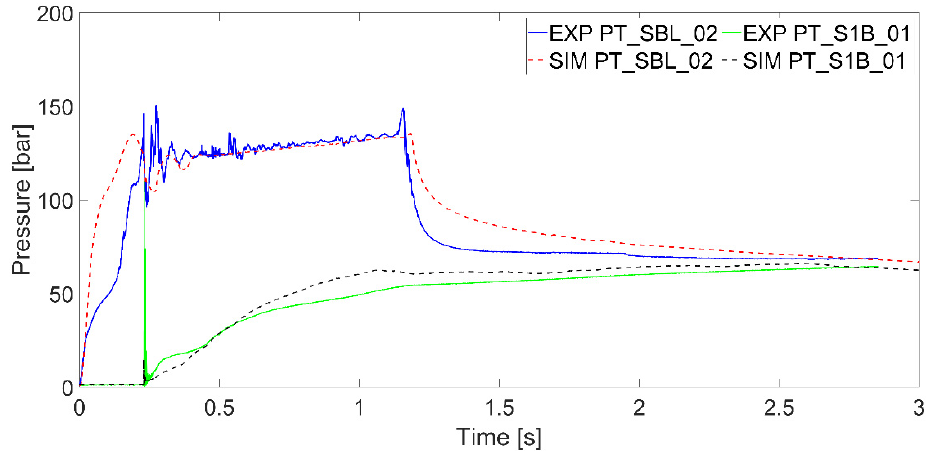
Figure 15. Coupled simulation—pressure evolution in the injection line and in S1B, compared with experimental data (PT).